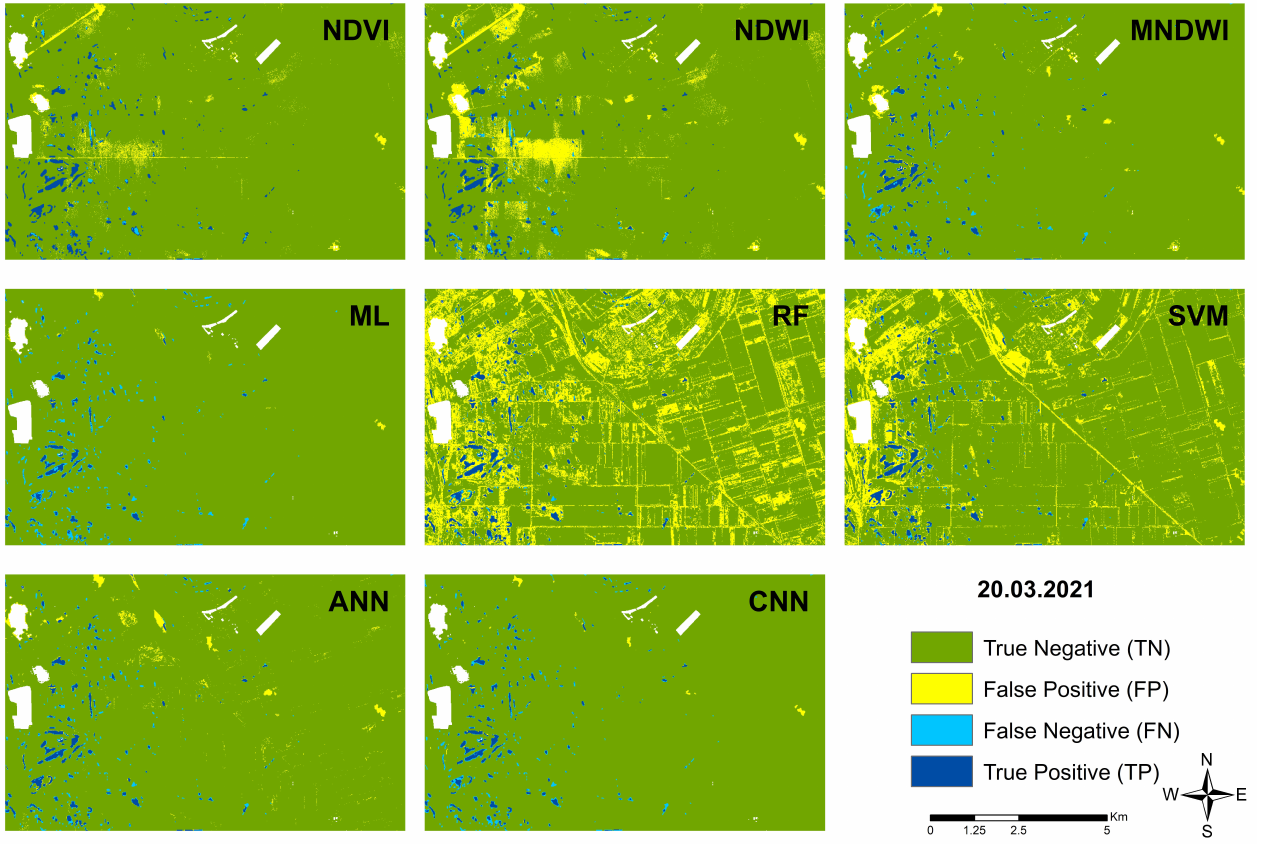
Figure 8. Results of the different classification on 20 March 2021.